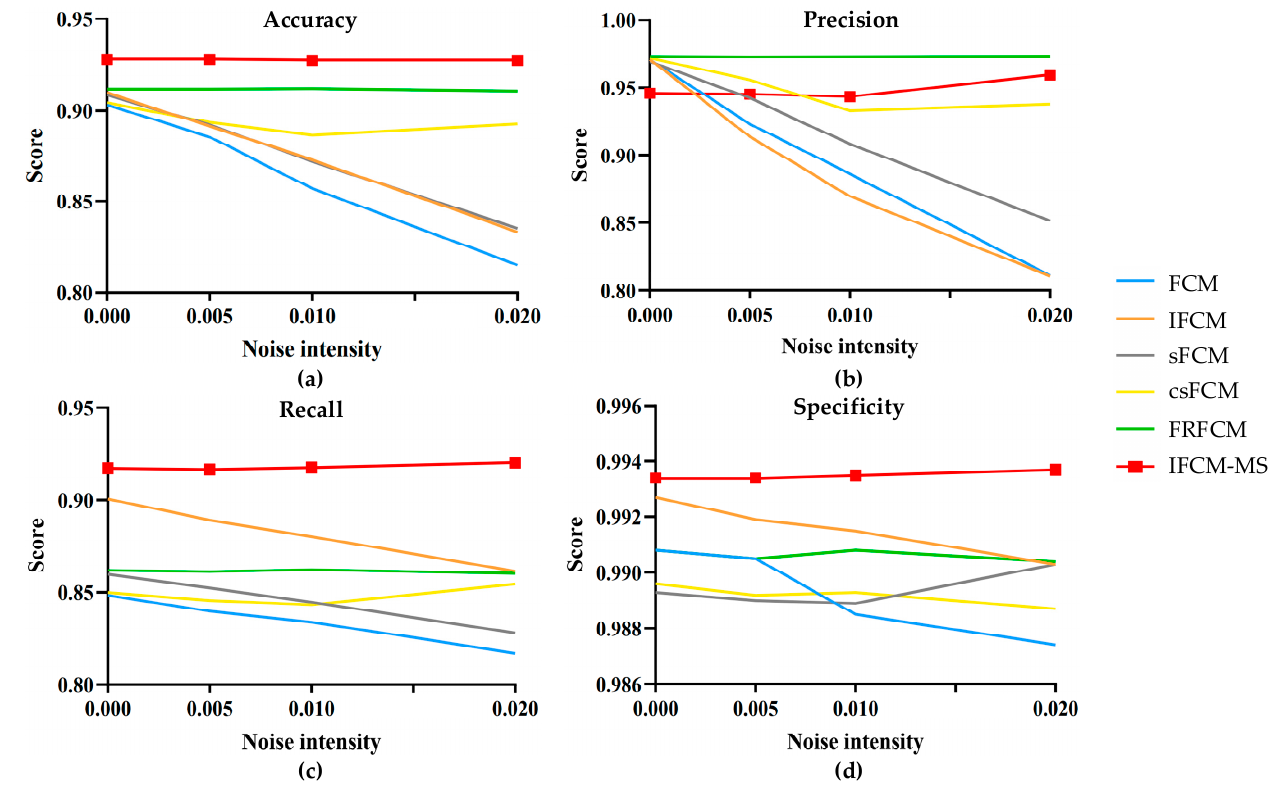
Figure 5. The change of each index value under different noise intensities. ( a ) Accuracy. ( b ) Precision. ( c ) Recall. ( d ) Spec- ificity.